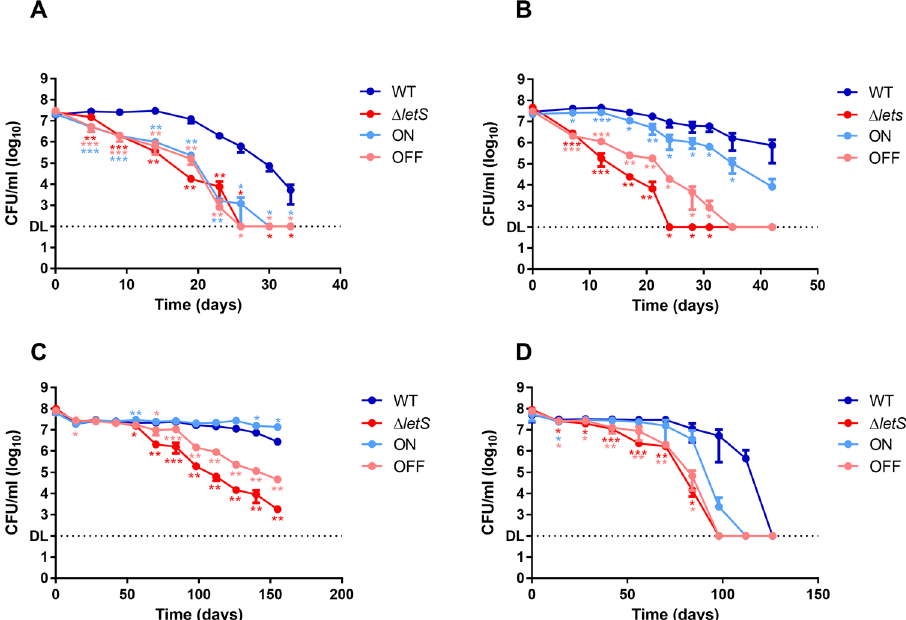
Figure 1. LetS increases the culturability of Lp in water. ( A and B ) CFU counts of the WT, ∆ letS and the induced (ON) or uninduced (OFF) ∆ letS + p letS was monitored in water at 42 °C. In panel A, ON was induced only in water, while in panel B, the ON strain was induced on agar prior to water exposure and during water exposure. Panel C and D show CFU counts of the WT, ∆ letS , ON and OFF at 4 °C and 25 °C respectively. The ON strain in panels C and D was induced on agar prior to water exposure and during water exposure. Strains were suspended in water at an OD 600 of 0.02. ON was induced with 0.1 mM IPTG. DL, detection limit. An unpaired, one-tailed Student’s t-test was used to assess statistical significance versus the WT. * p < 0.05; ** p < 0.005; *** p <